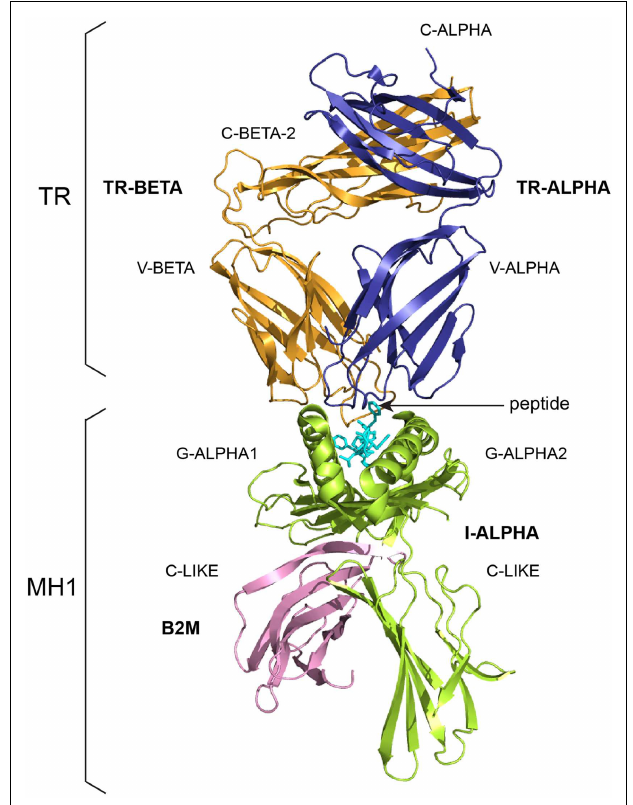
FIGURE 2 |AT cell receptor (TR)/peptide-major histocompatibility 1 (pMH1) complex . ATR (here,TR-alpha_beta) is shown (on top, upside down) in complex with an MH (here, MH1) presenting a peptide in its groove. In vivo , aTR is anchored in the membrane of aT cell as part of the signalingT cell receptor (TcR = TR + CD3). ATR is made of two chains, each comprising a variable domain (V-DOMAIN) at the N-terminal end and a constant domain (C-DOMAIN) at the C-terminal end (3).The domains are V-ALPHA and C-ALPHA for theTR-ALPHA chain,V-BETA and C-BETA for the TR-BETA chain ( Table 2 ) (3). An MH1 is made of the I-ALPHA chain with two G-DOMAIN (G-ALPHA1 and G-ALPHA2) and a C-LIKE-DOMAIN (C-LIKE), non-covalently associated with the B2M (a C-LIKE-DOMAIN) (8).The TR/pMH1 complex structure is 3qfj from IMGT/3Dstructure-DB